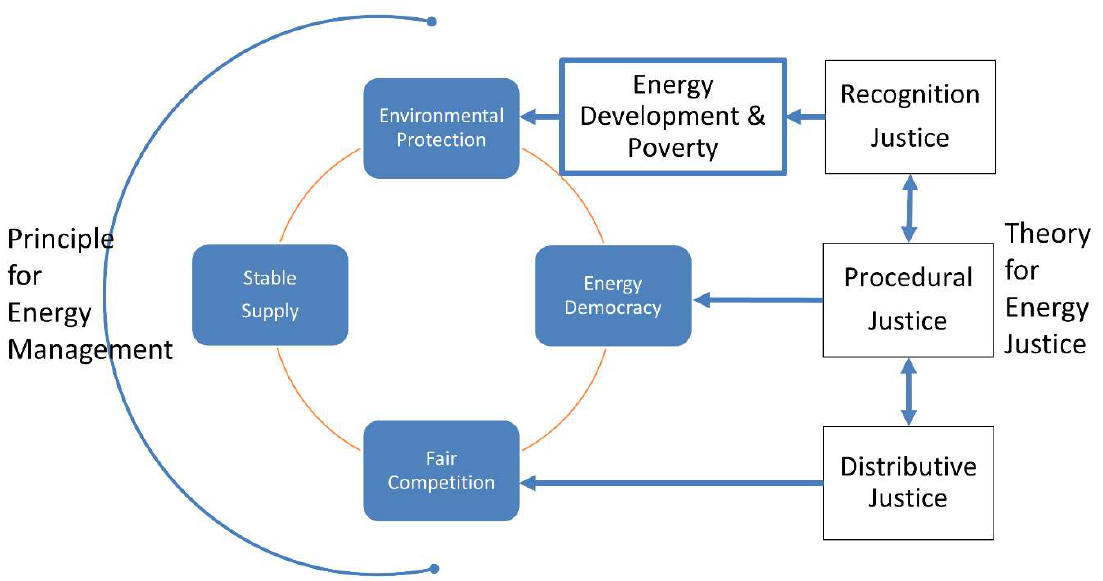
Figure 1. Analytical framework for national energy transition.